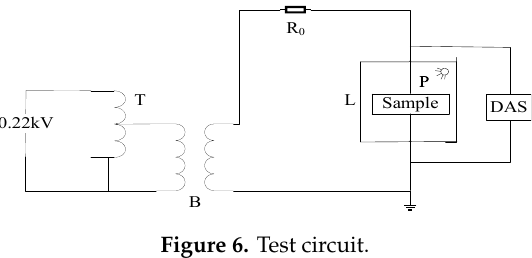
Figure 6. Test circuit.